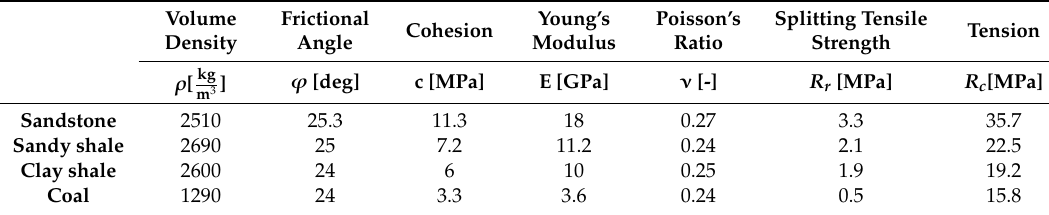
Table 1. Geomechanical parameters of geological